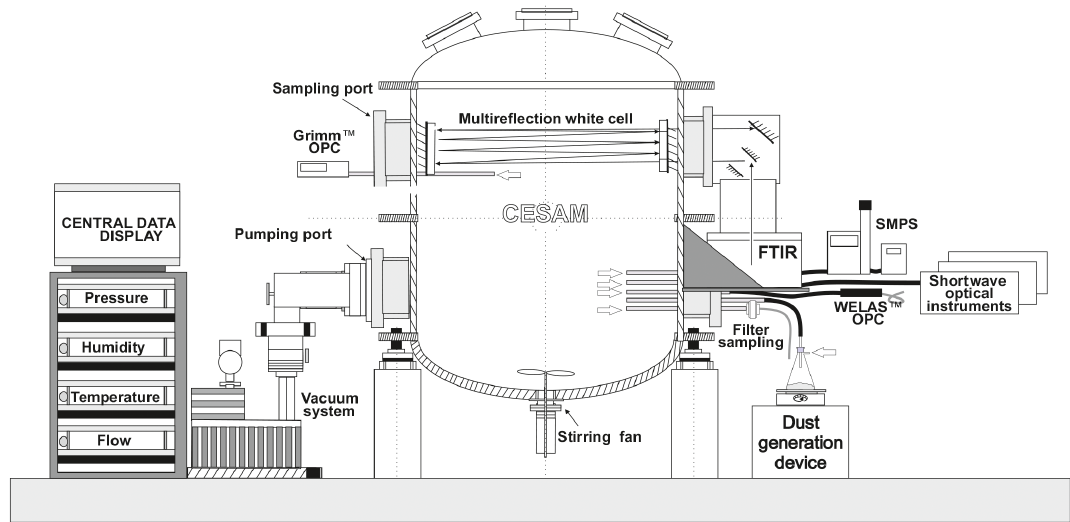
Figure 1. Schematic configuration of the CESAM set up for the dust experiments. The dust generation (vibrating plate, Büchner flask containing the soil sample) and injection system is shown at the bottom on the right side. The position of the SMPS, WELAS, and SkyGrimm used for measuring the size distribution, FTIR spectrometer, SW optical instruments, and filter sampling system are also